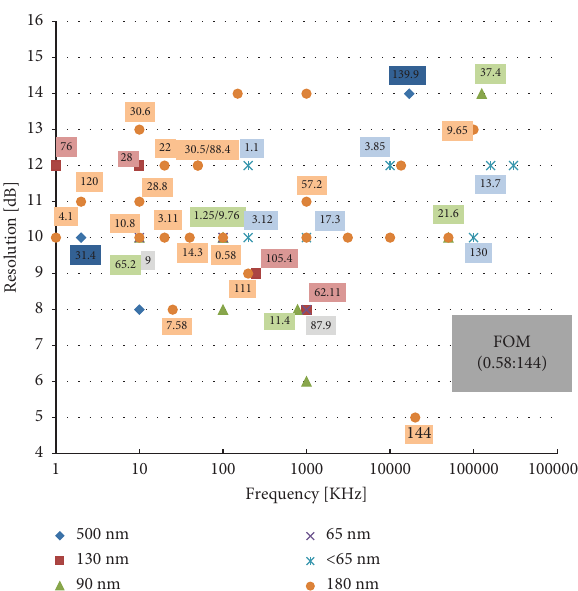
Figure 38: Single SAR ADC performance survey (2017–2021).